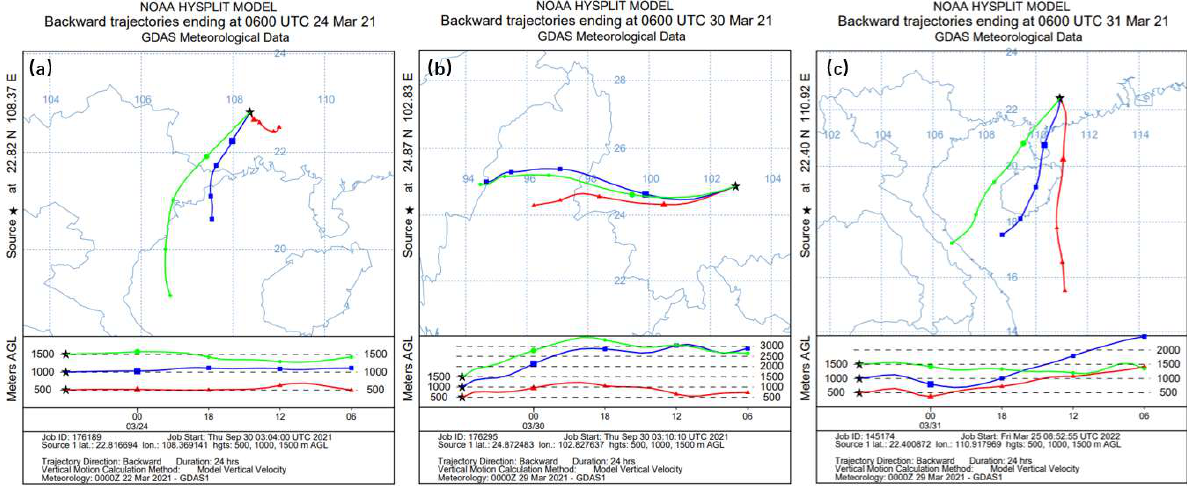
Figure 9. Backward trajectories of polluting air mass in Guangxi on 24 March ( a ) Yunnan on 30 March, ( b ) and Guangdong on 31 March, ( c ) at different altitudes above ground level. (Red: 500 m; Blue: 1000 m; Green: 1500 m).